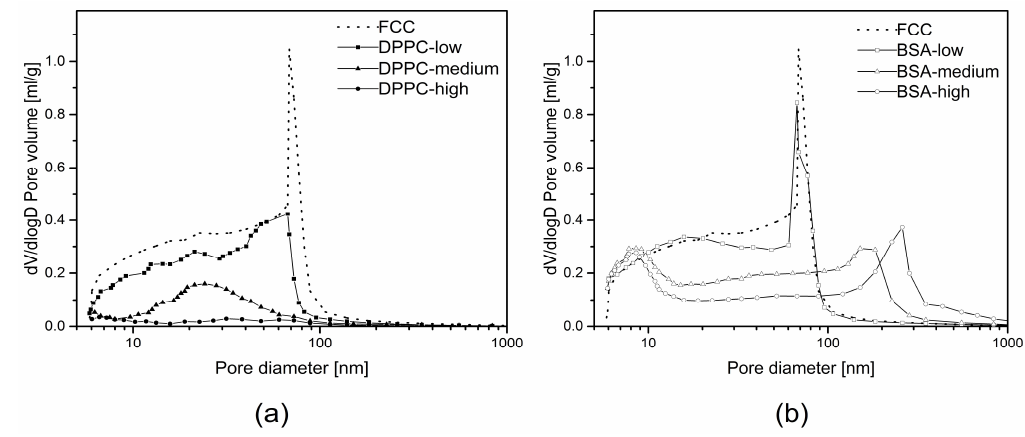
Figure 2. Pore size distribution obtained from mercury intrusion porosimetry. ( a ) Dipalmitoylphosphatidylcholine (DPPC) and ( b ) bovine serum albumin (BSA) loaded functionalized calcium carbonate (FCC) particles. Drug loads are defined in Table 1. Reference material was unloaded FCC. Samples were consolidated to exclude interparticulate pores. Smoothed curves represent means of n = 3 measurements.